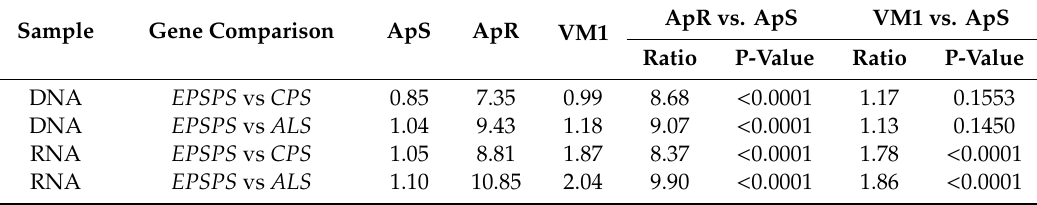
Table 2. Average EPSPS gene copy number and expression relative to ALS and CPS genes for the ApS, ApR and VM1 populations.